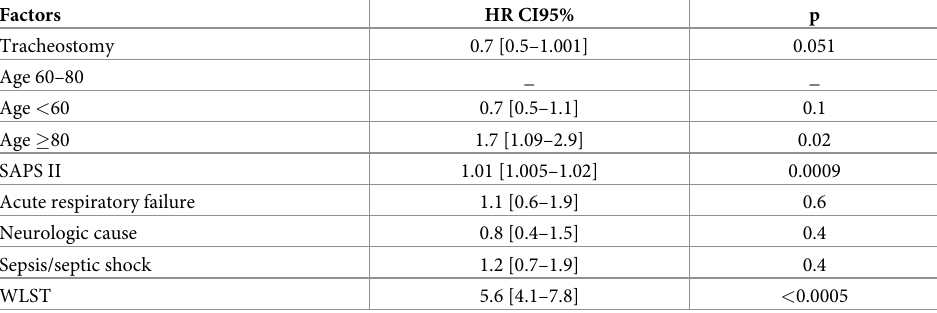
Table 2. Cox-adjusted analysis regression model on one-year mortality in patients with prolonged MV with or without